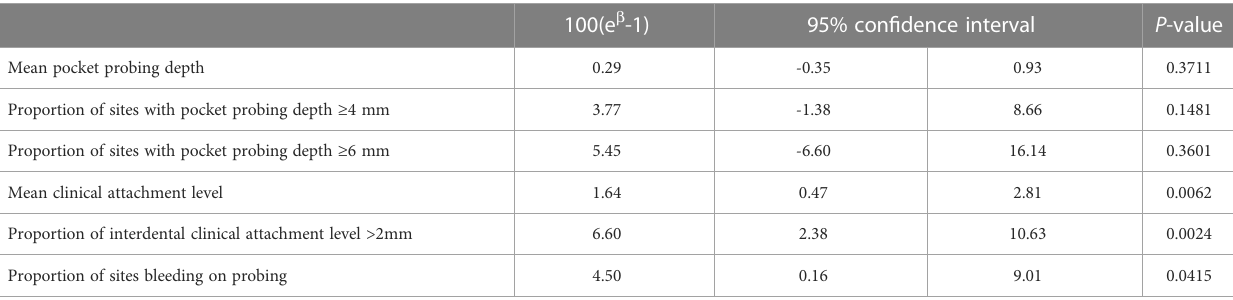
TABLE 4 Confounder-adjusted associations between baseline serum cortisol and follow-up periodontal measurements in complete case analysis of the Study of Health in Pomerania.